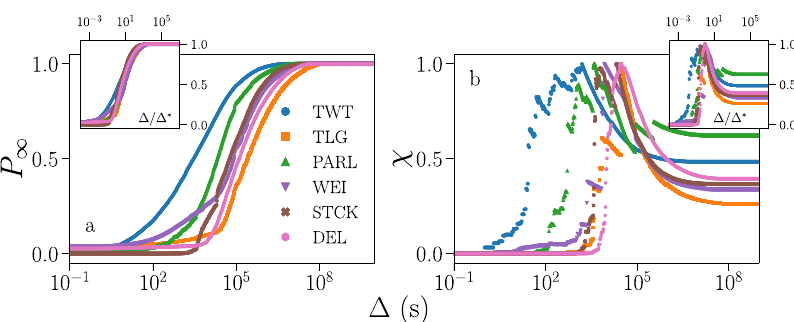
Fig. 1 Universality of information propagation in online social media. a In the main panel, we show the percolation strength P ∞ as a function of the temporal resolution Δ , see Eq. (1). The unit of measurement for Δ is one second. Different colors/symbols refer to different social media: Twitter (TWT), Telegram (TLG), Parler (PARL), Weibo (WEI), StackOver fl ow (STCK), and Delicious (DEL). In the inset, we plot the same data as in the main panel, but with the horizontal axis rescaled as Δ → Δ / Δ * . b In the main panel, we plot the susceptibility χ as a function of the time resolution for the same data as in A, see Eq. (1). The optimal resolution Δ * is identi fi ed as the location of the peak of the susceptibility, see Eq. (2). In the inset, we plot the same data as in the main panel, but with the rescaling Δ → Δ / Δ * . For the sake of comparison, each curve has been normalized to its maximum χ * , see Methods.